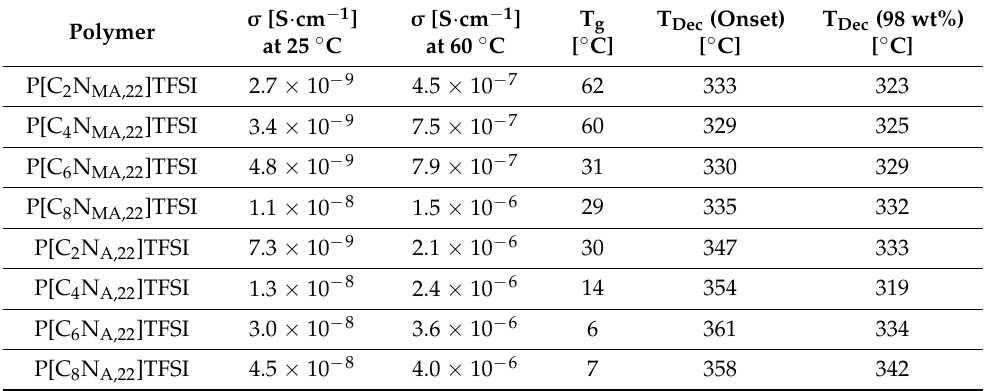
Table 1. Physicochemical properties of the neat polymerized ionic liquids, including ionic conductiv- ity values at 25 ◦ C, glass transition temperatures (T g ), onset temperature of thermal decomposition (T Dec (Onset)) and temperature at which 98 wt% of the sample mass is remaining in thermogravimet- ric analysis (T Dec (98